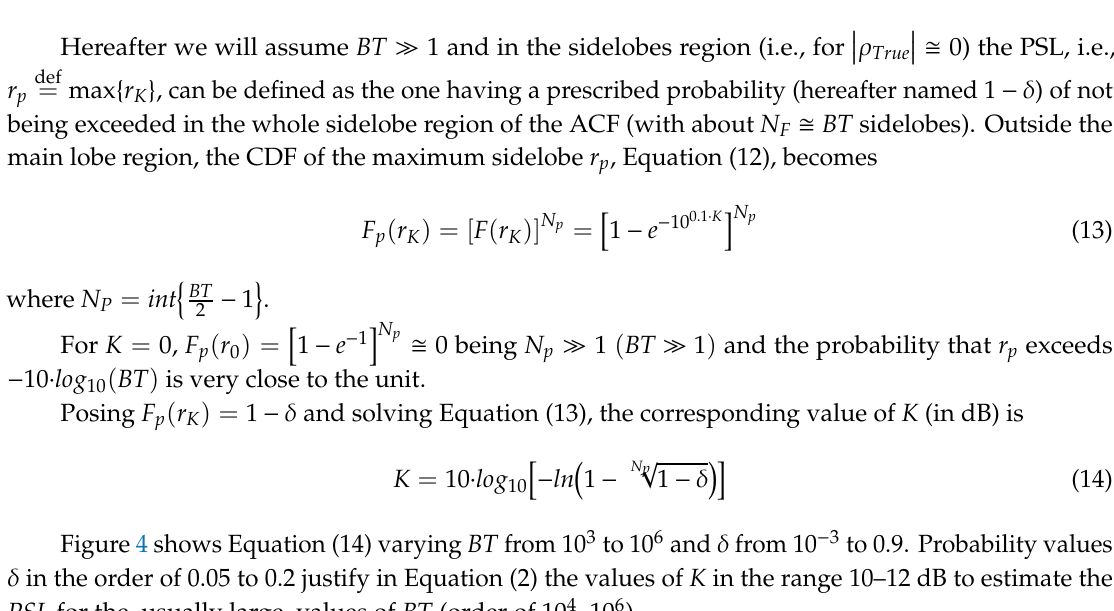
Figure 4. Parameter (cid:1837) (dB), as defined in Equation (2), versus (cid:2012) with BT varying, Equation (14).